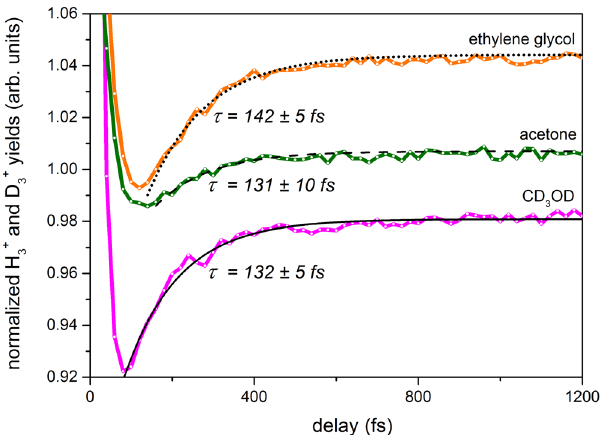
Figure 7. Normalized H 3 + and D 3 + yields from dissociative ionization of different organic molecules as a function of pump-probe delay. Shown in the figure are H 3 + from ethylene glycol (orange solid line), H 3 + from acetone (green solid line), and D 3 + from CD 3 OD (magenta solid line). Normalization was performed with respect to the yields at negative time delays (see Fig. 5). Corresponding exponential fits are shown by black